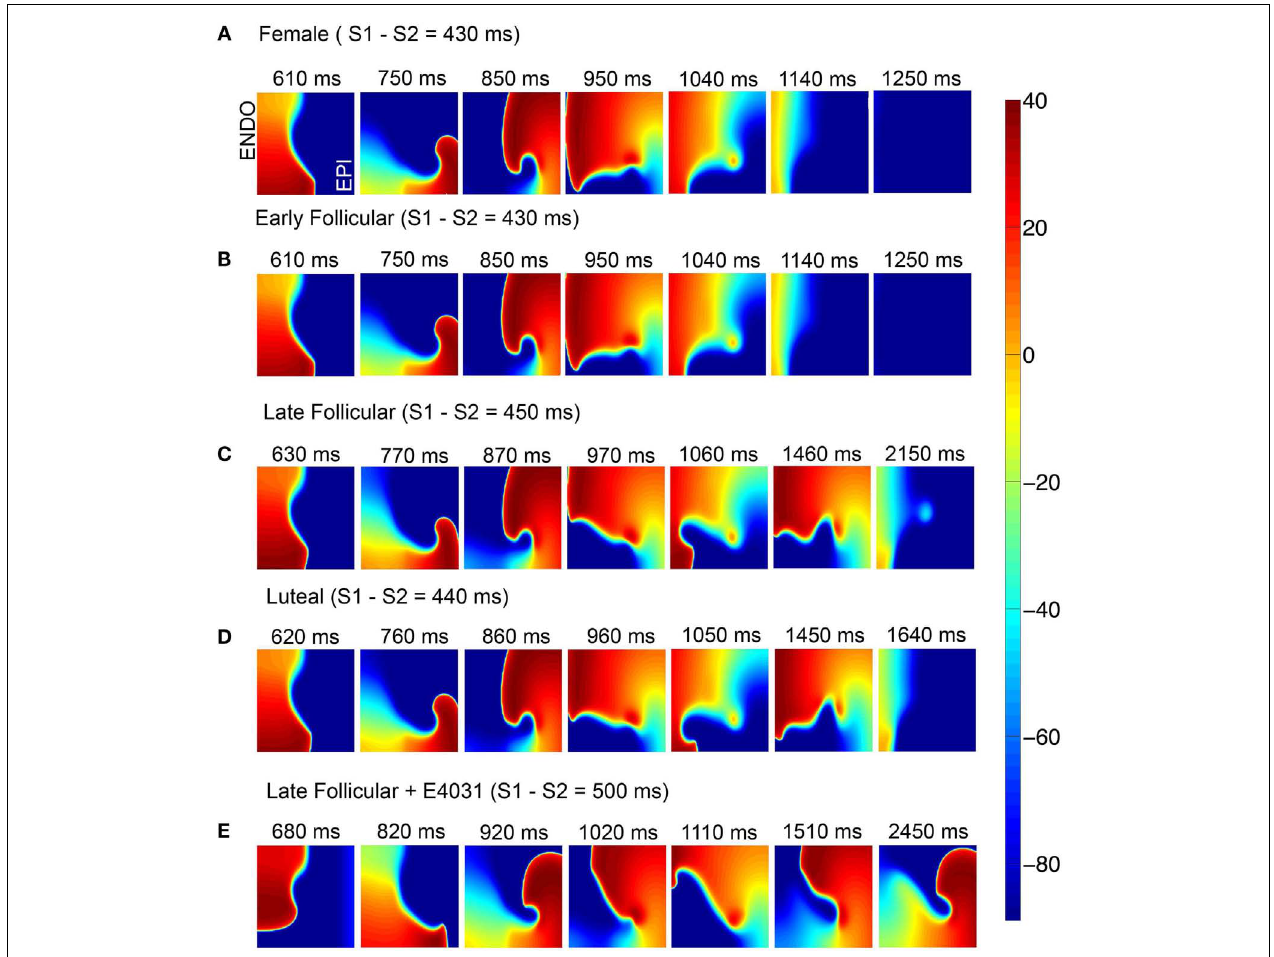
FIGURE 6 |Attempted induction of reentry in female heterogeneous tissues in the absence (A) or presence of female hormones (B–D) and I Kr block during late follicular phase (E). Seven snapshots following application of hormones and/or drug at indicated time points.The protocol was as in Figure 5